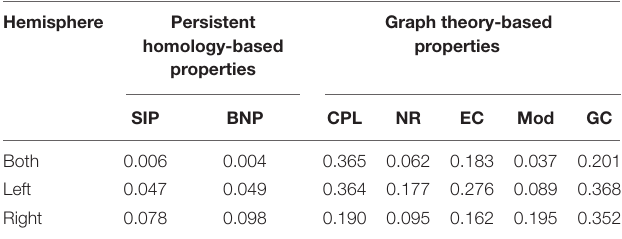
right one. Moreover, compared to experiments performed on